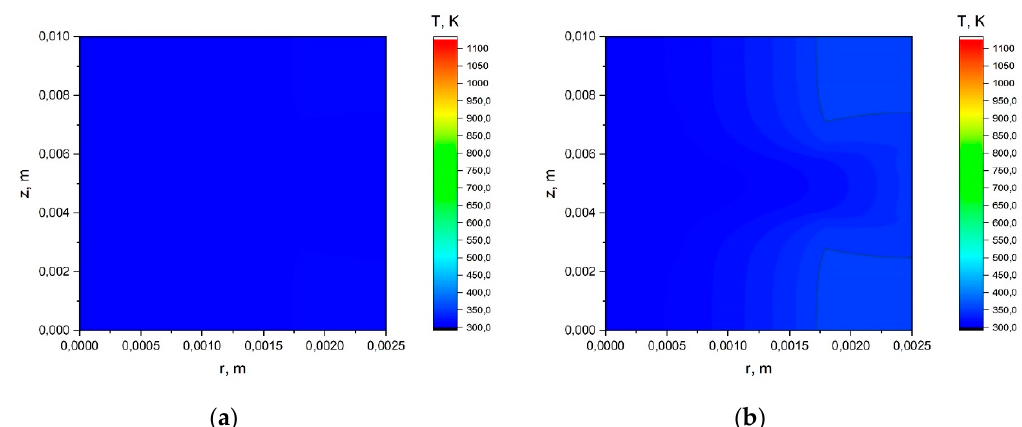
Figure A21. Temperature distribution in the stem of a herbaceous plant: R = 0.0025 m, t = 3 s, q = 0.5 kW/m 2 ( a ); R = 0.0025 m, t = 3 s, q = 3 kW/m 2 ( b ).